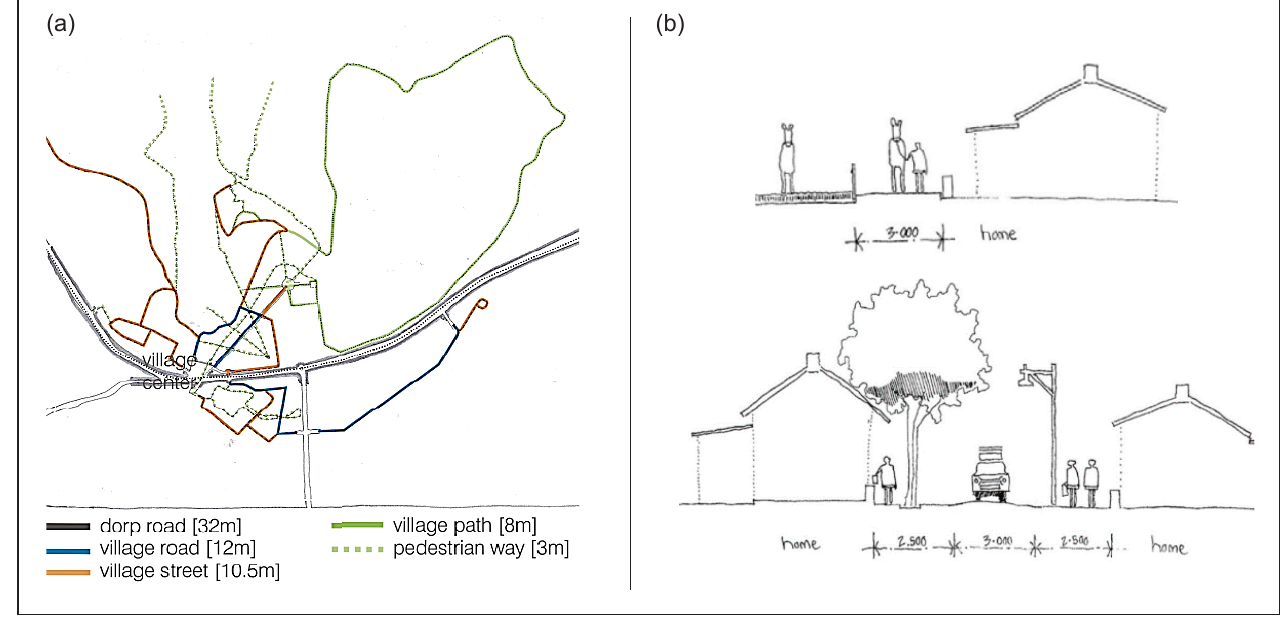
Figure 8: (a) Connectivity framework; (b) Selected examples of detailed street reserve designs Source: GWA Studio, 2014: 10, 17